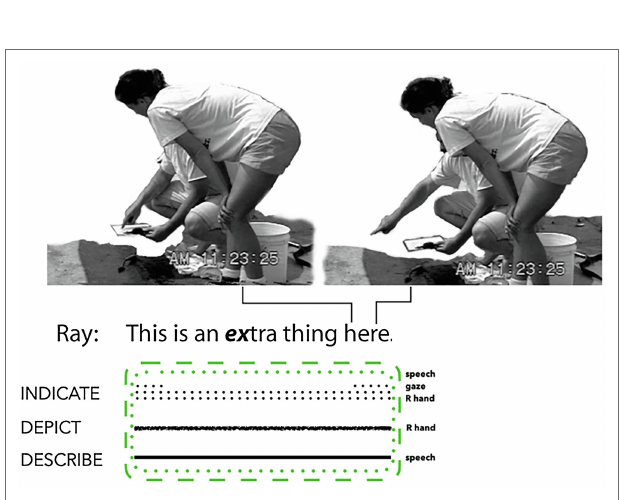
FIGURE 5 | Composite utterance produced by a hearing English speaker (adapted from Goodwin, 2003: 229 and reproduced with permission from Taylor and Francis Group, LLC., a division of Informa